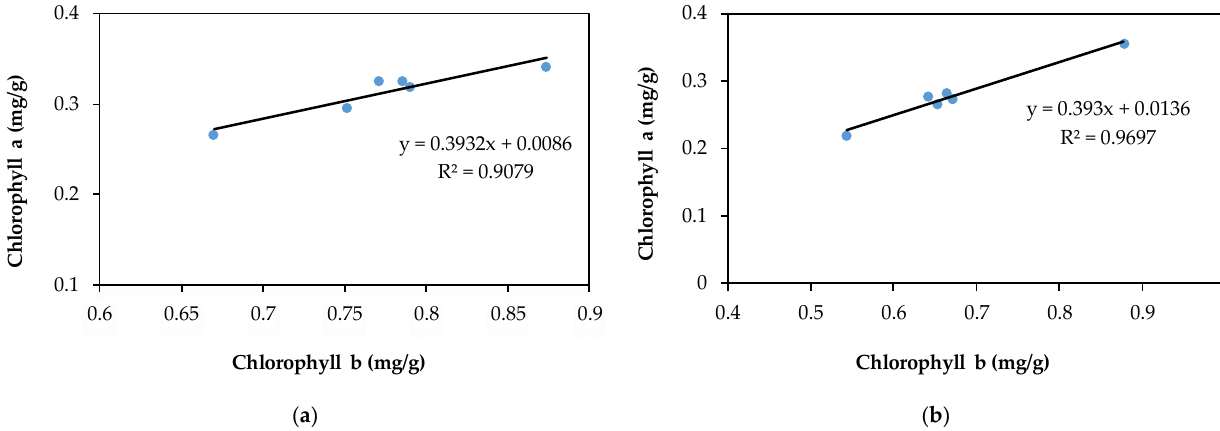
Figure 9. The linear relationship between chlorophyll a and b pigments in rapeseed leaves exposed to different concentra- tions of lead ( a ) and cadmium ( b ).